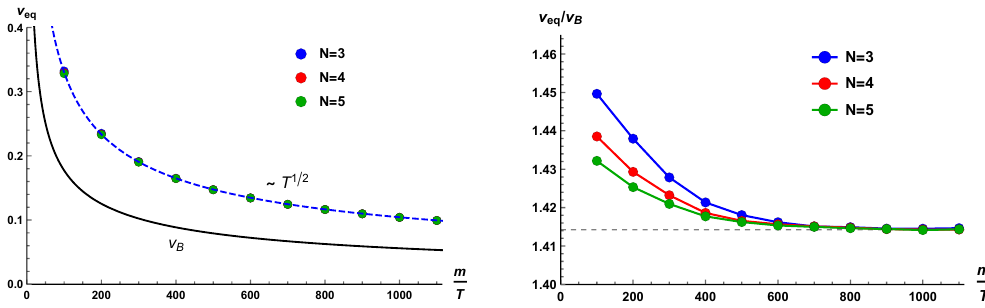
Figure 5 . Left: the behaviour of the equilibration velocity in function of the dimensionless tem- perature m/T for various values of N = 3 , 4 , 5 . The dashed line shows the T 1 / 2 scaling. right: the comparison with the butterfly velocity. At low temperatures, the ratio of the two velocities √ √ approach a constant value, ∆ = 2 0